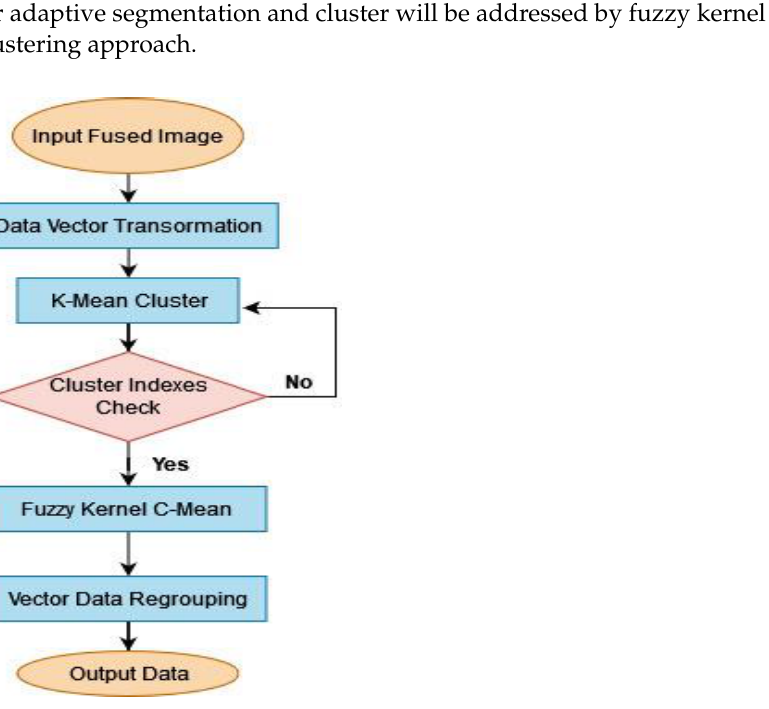
Figure 4. Proposed hybrid fuzzy segmentation model.